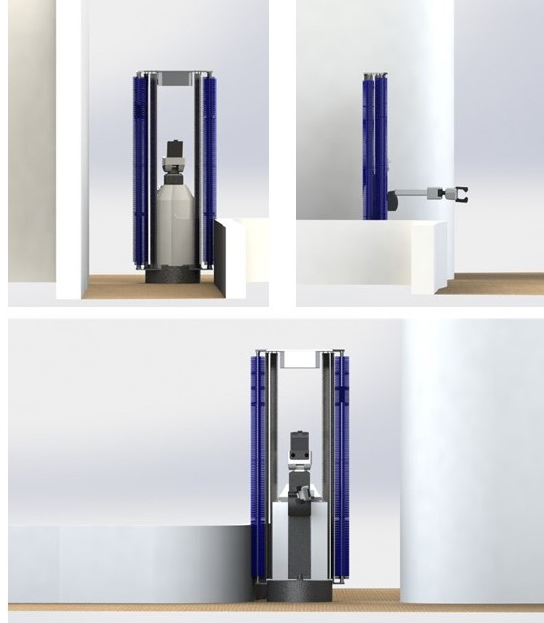
Figure 10. HSR Robot with cleaning